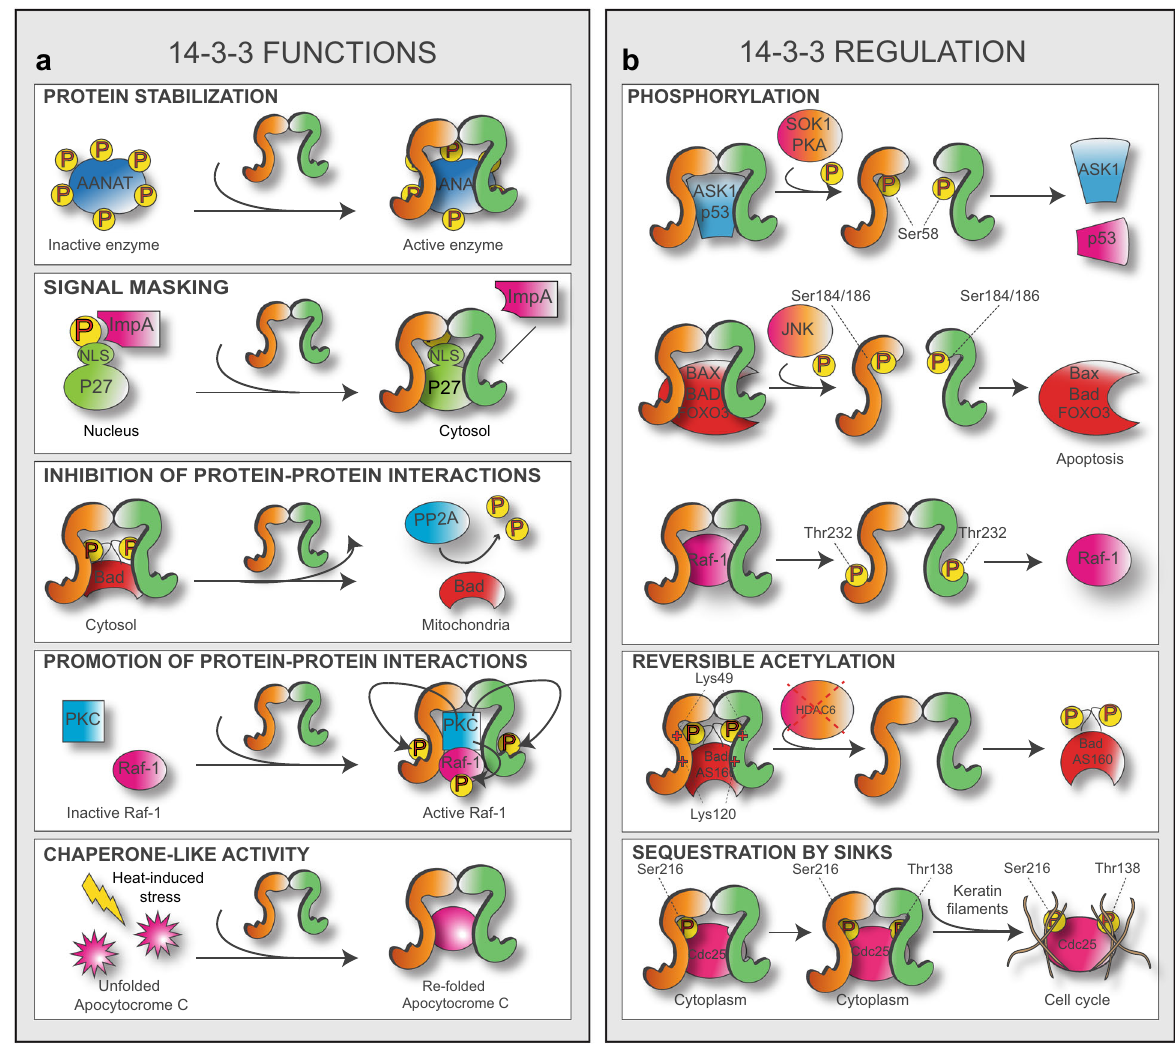
Fig. 2 Modi fi cations and modalities of function of 14-3-3. Panels in a and b show some of the diverse modalities of activity and regulation of 14-3-3s as described in the main text. P: phosphate group; AANAT: serotonin N-acetyltransferase; ImpA: importin α ; NLS: nuclear localization signal; BAD: BCL2 associated agonist of cell death; PP2A: protein phosphatase 2; PKC: protein kinase C; Raf-1; ASK1: apoptosis signal-regulating kinase 1; SOK1; PKA: protein kinase A; BAX: BCL2 associated X; FOXO3: forkhead box class O 3; JNK: c-Jun N-terminal kinases; AS160: Akt substrate of 160 kDa;